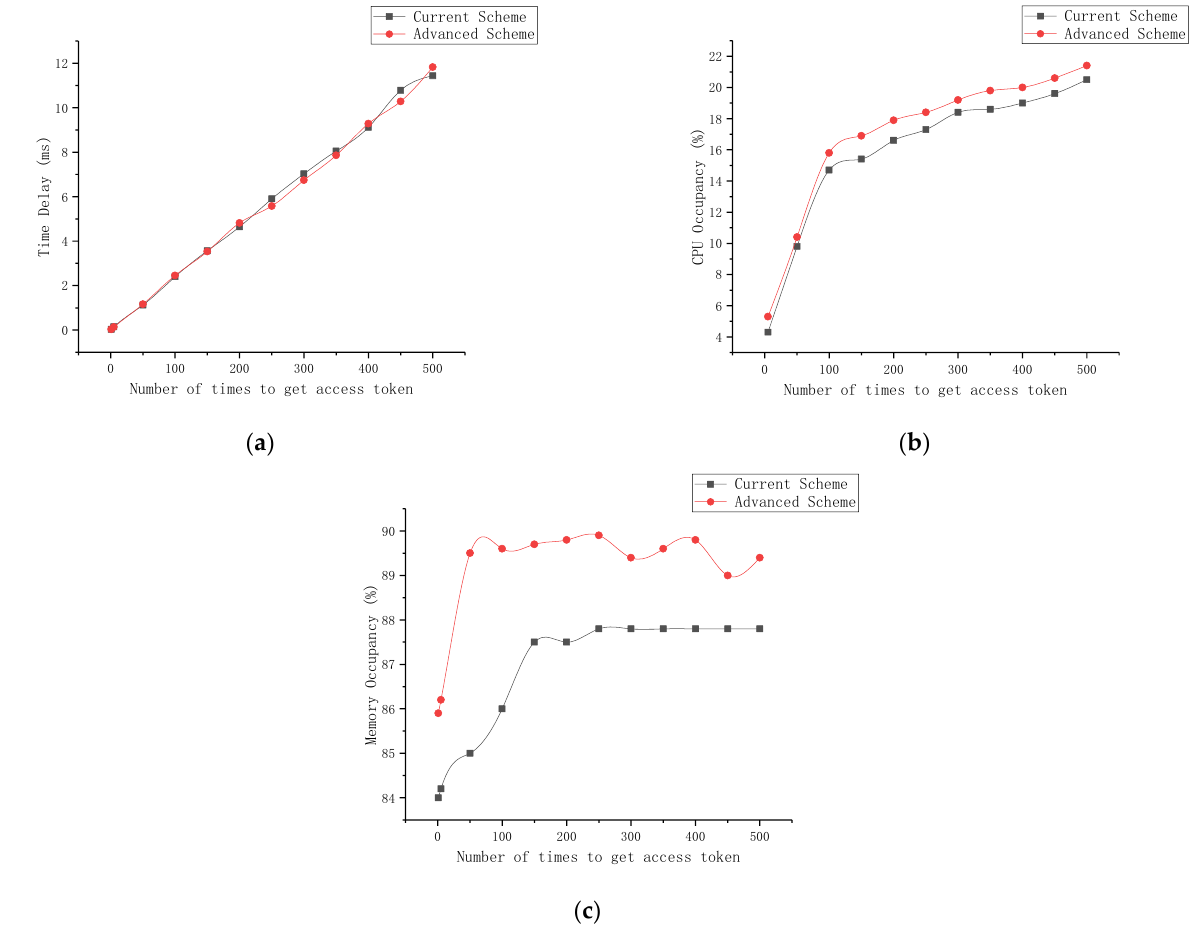
Figure 13. Diagram of performance evaluation experiment results. ( a ) Time Delay. ( b ) CPU Occu- pancy. ( c ) Memory Occupancy.